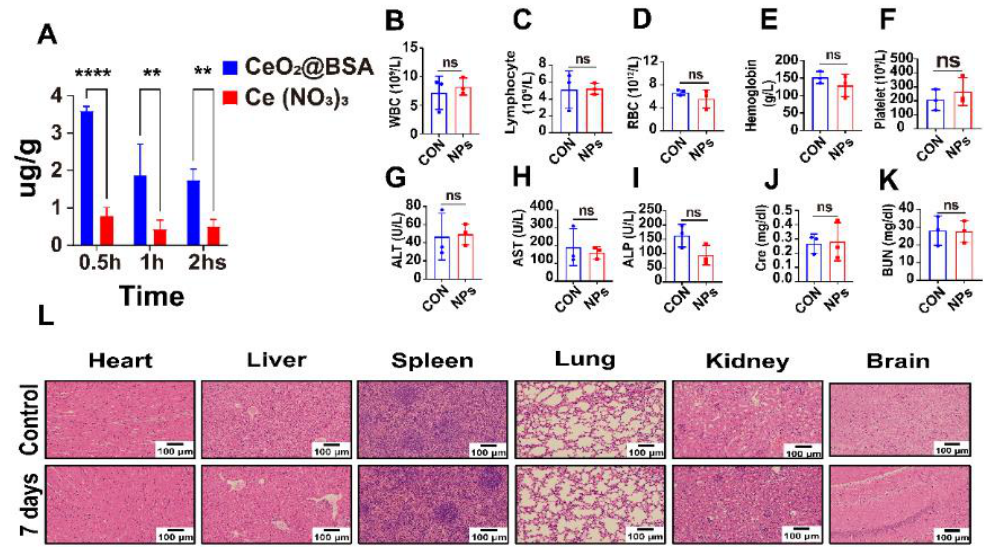
Figure 7. In vivo metabolism and biocompatibility of CeO 2 @BSA NPs. ( A ) Cardiac uptake of CeO 2 @BSA NPs and the equivalent cerium content of Ce(NO 3 ) 3 at different time points after tail vein injection. ( B – F ) Analysis of the blood routine examination of WBC ( B ), lymphocytes ( C ), RBC ( D ), hemoglobin ( E ), and platelets ( F ) in the two groups. ( G – I ). Analysis of the liver function via ALT ( G ), AST (H), and ALP ( I ) in the two groups. ( J , K ) Analysis of the renal function via Cre ( J ) and BUN ( K ) in the two groups. ( L ). Representative HE staining of heart, liver, spleen, lung, kidney, and brain in the two groups after a week of treatment, scale bar = 100 µ m. WBC: white blood cell, RBC: red blood cell, ALT: alanine transaminase, AST: aspartate transaminase, ALP: alkaline phosphatase, Cre: creatinine, BUN: blood urea nitrogen, HE staining: hematoxylin/eosin (HE). Data are expressed as mean ± SEM of three independent replicates; ** p < 0.01, **** p < 0.001, ns: no statistical